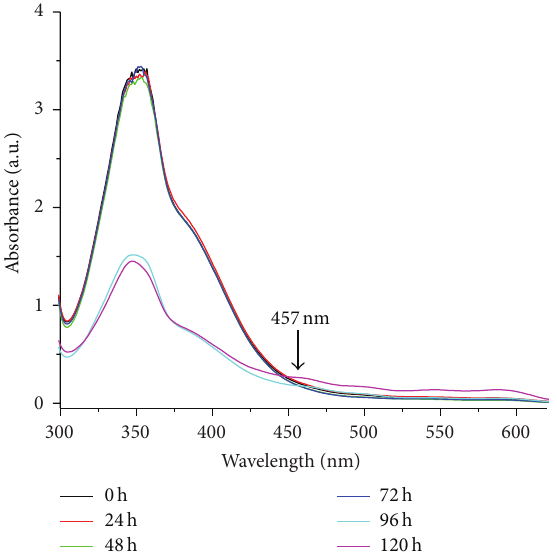
Figure 10: Absorbance of TFN:DDQ complex in acetonitrile at different time points (to determine concentration, the value of absorbance intensity at 457 nm was recorded and compared with value in calibration curve).